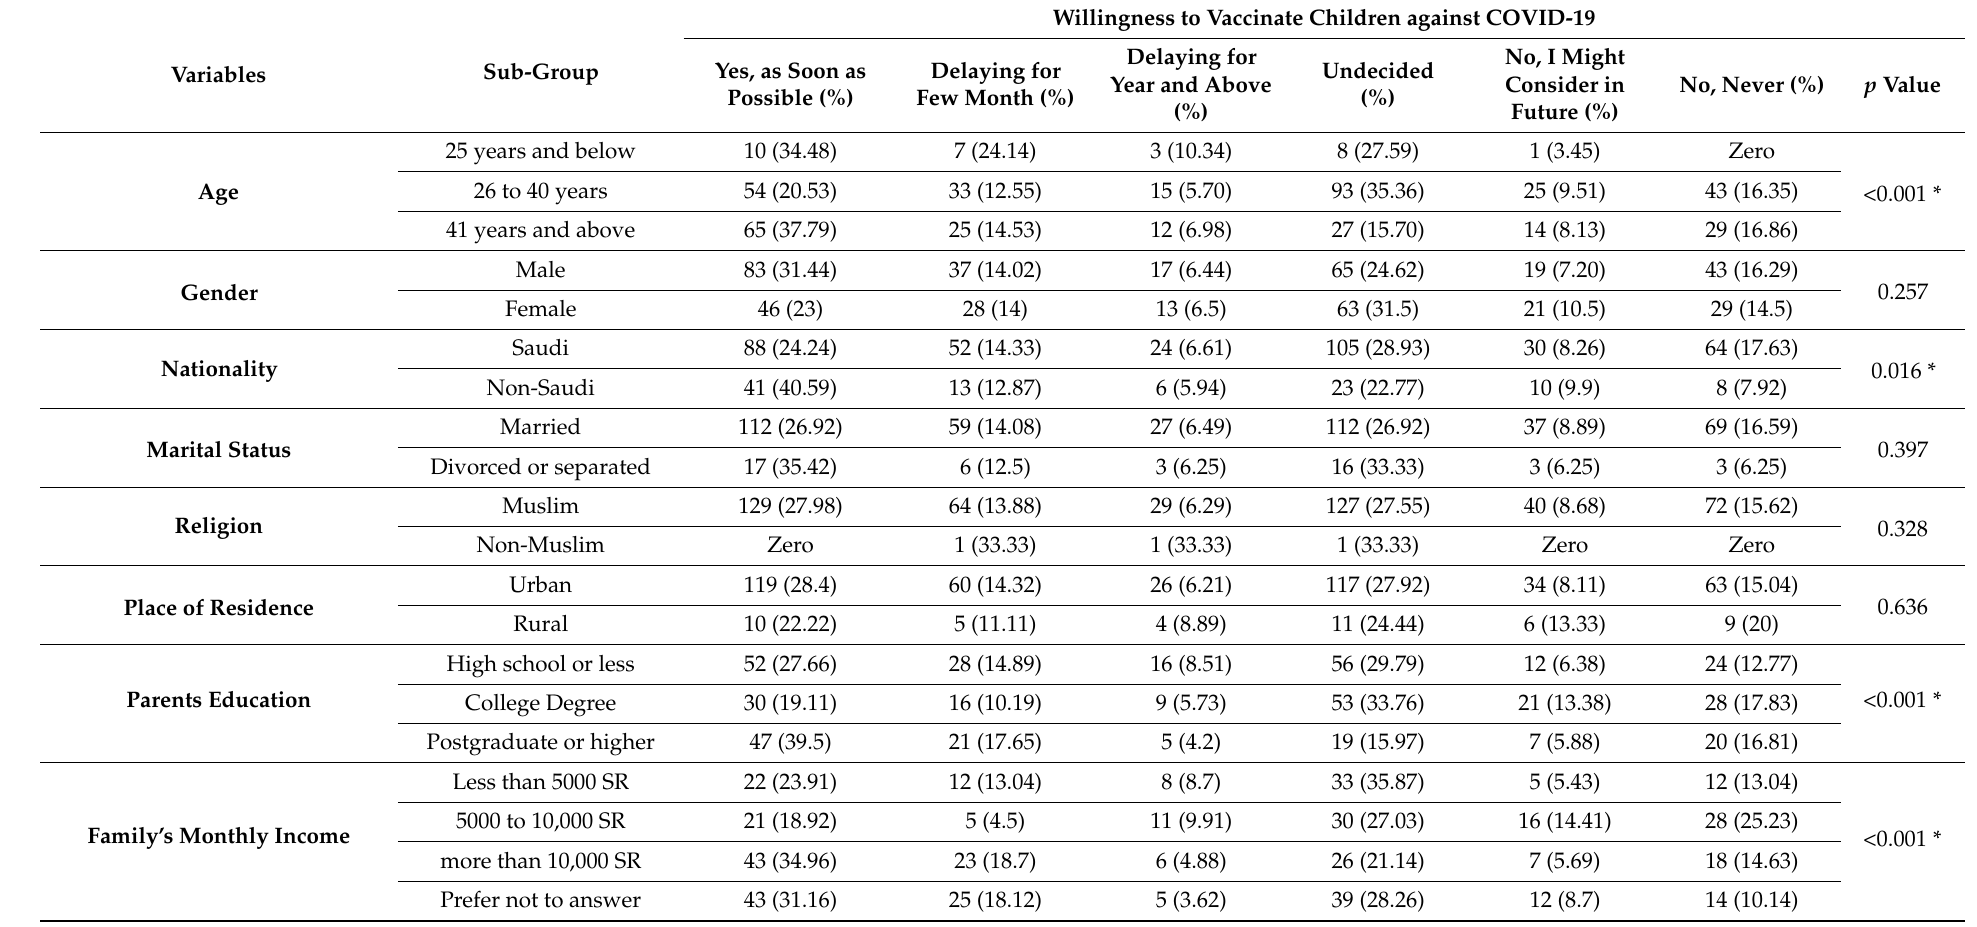
Table 2. Association between demographic variables and parents’ willingness to vaccinate their children with COVID-19 vaccines.